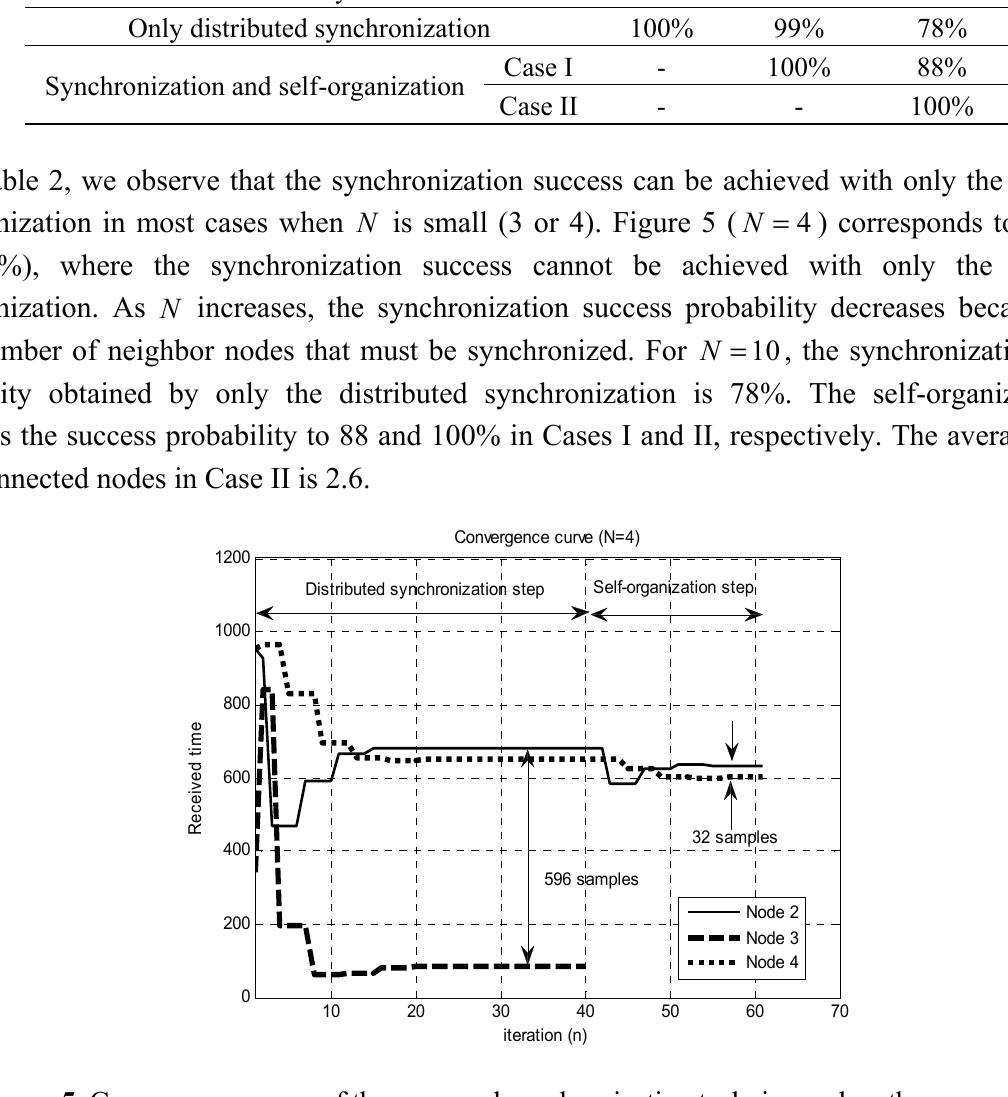
Figure 5. Convergence curve of the proposed synchronization technique when the propagation